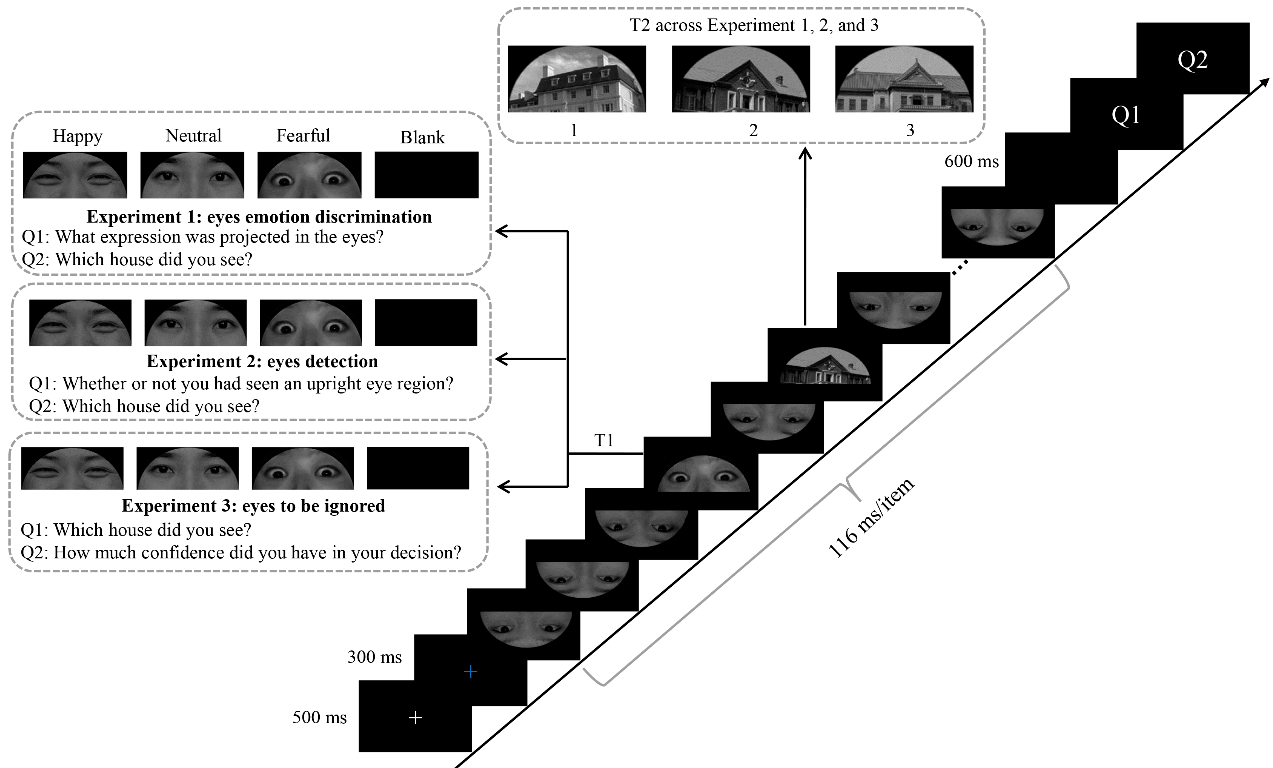
Figure 1. Experimental design and diagram of a representative trial.